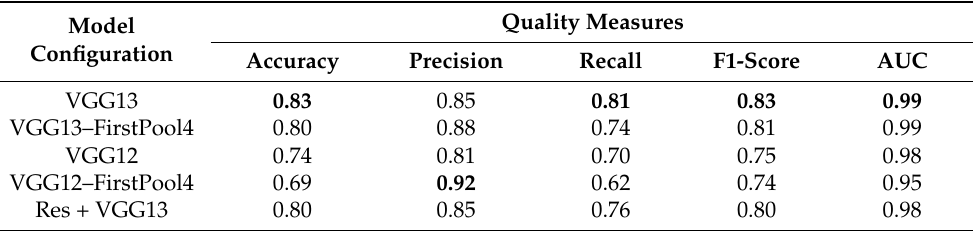
Table 1. Models with various CNN architectures and their measures of classification quality on the validation set. Best values are highlighted in bold. No processing or augmentation was used on the input images. Quality measures are defined in Methods. More details about network architectures are given in Table S1.